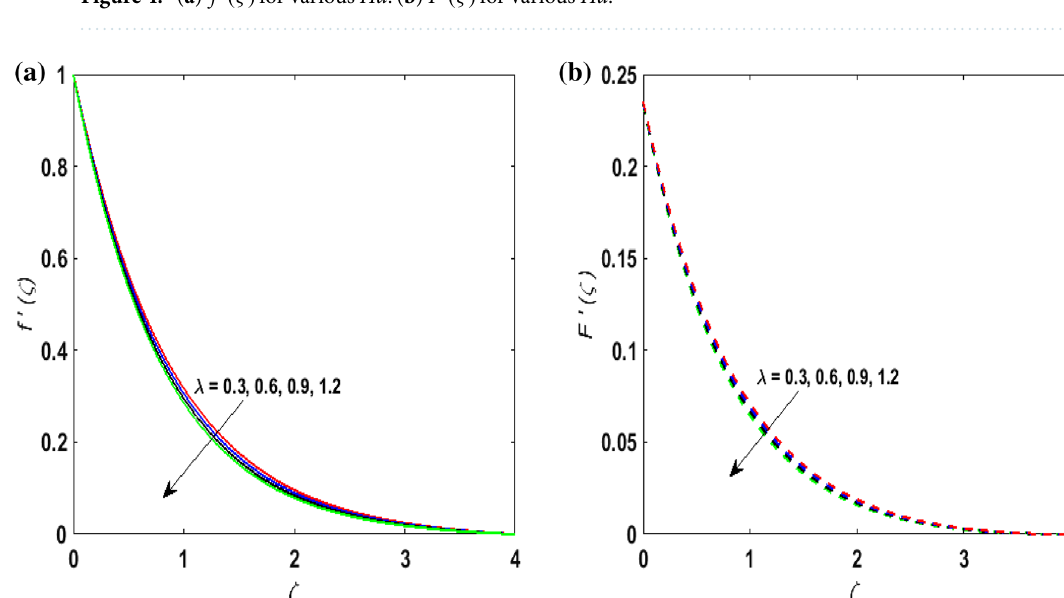
Figure 5. ( a ) f ′ (ζ) for various (cid:31) . ( b ) F ′ (ζ) for various (cid:31)